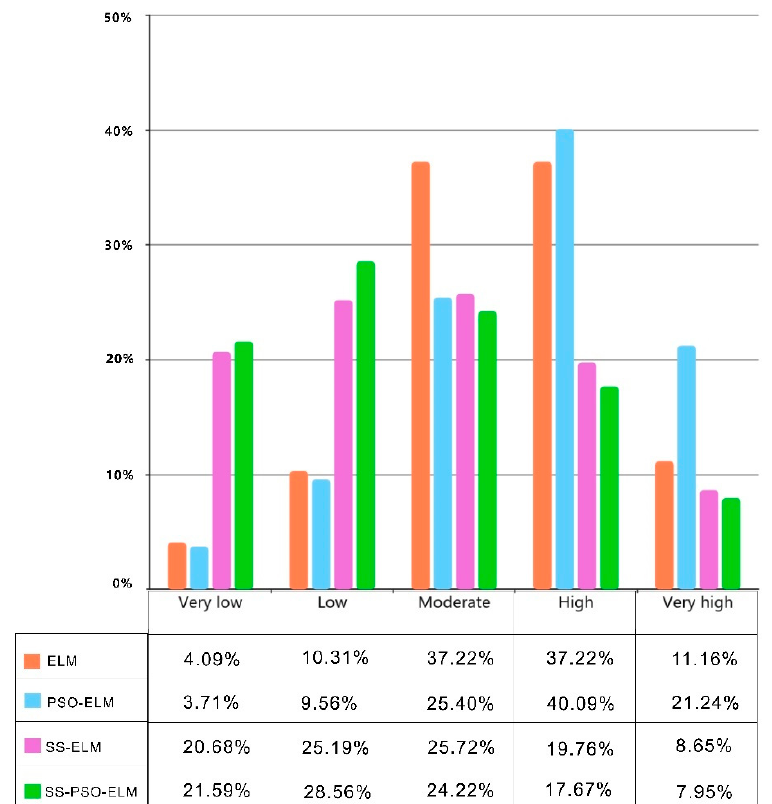
Figure 13. Model classification ratio chart.